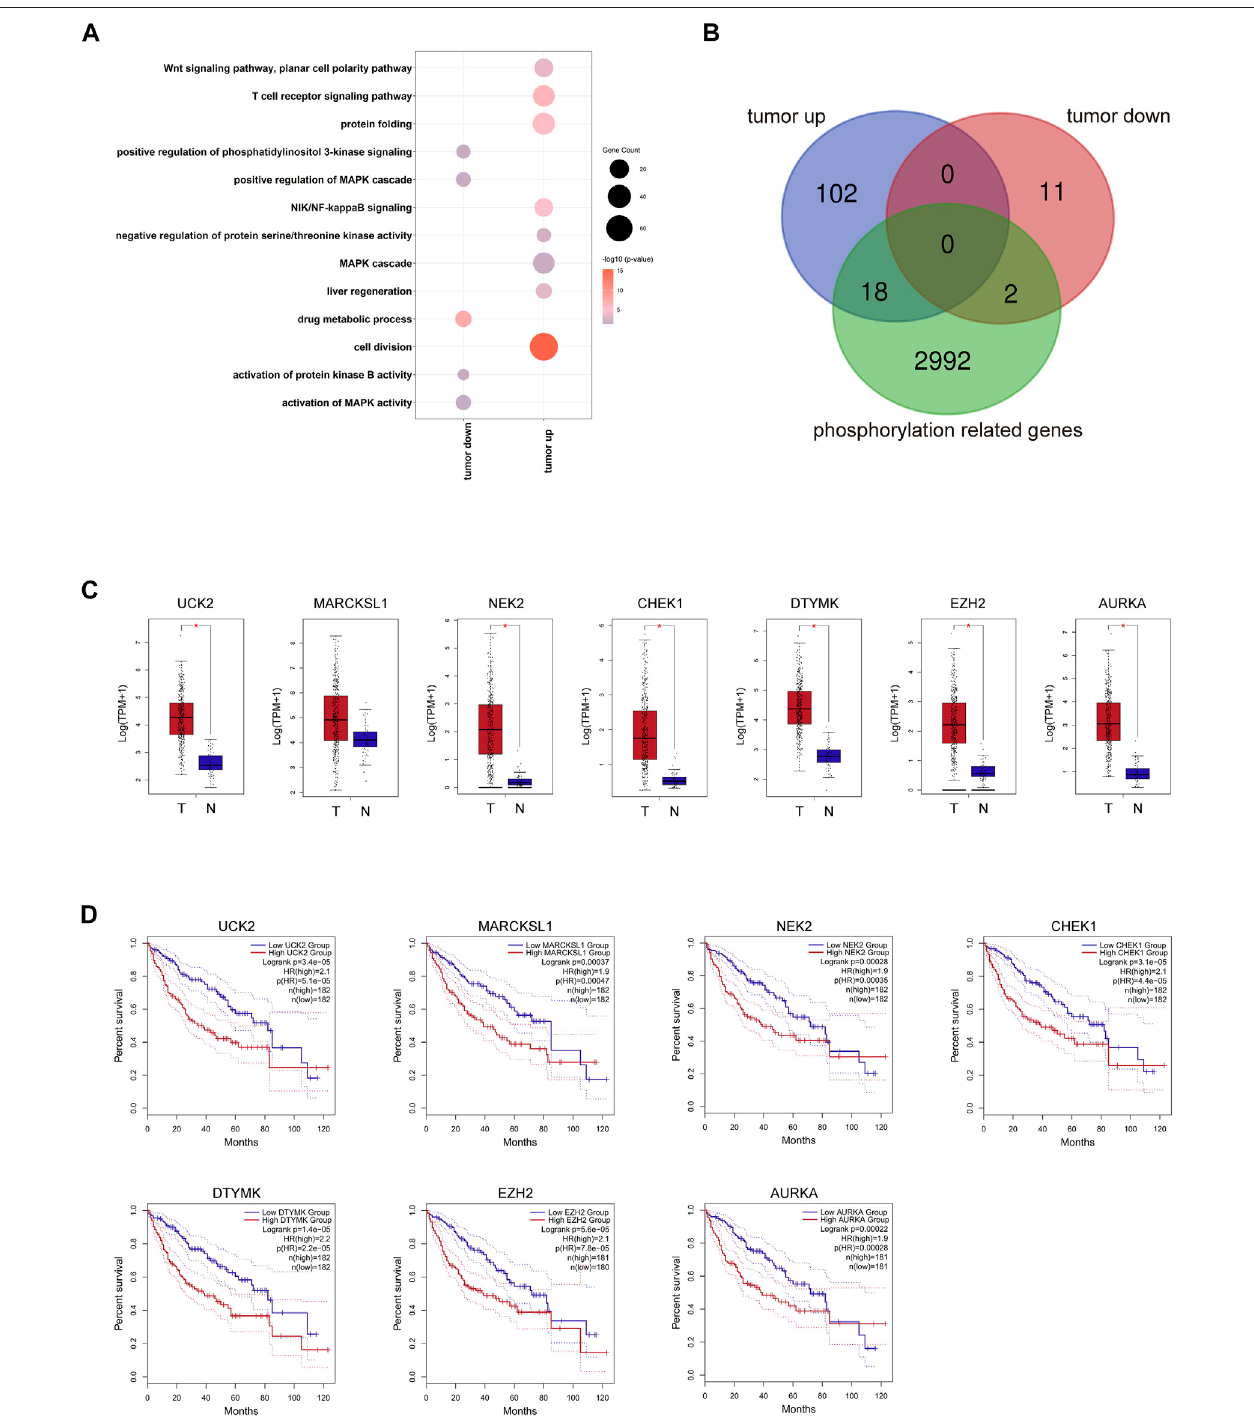
FIGURE 2 | Transcriptome pro fi ling of PRGs in the TCGA LIHC dataset. (A) Representative GO terms of HCC related DEGs. Dot size represents the gene counts, and dot color represents the signi fi cance. (B) The overlay of 120 prognosis-related and HCC upregulated DEGs, 13 prognosis-related and HCC downregulated DEGs, and 3,012 kinase-related genes. (C) Expression of seven representative PRGs. (D) Kaplan – Meier overall survival curves of TCGA LIHC patients grouped by seven representative PRGs.